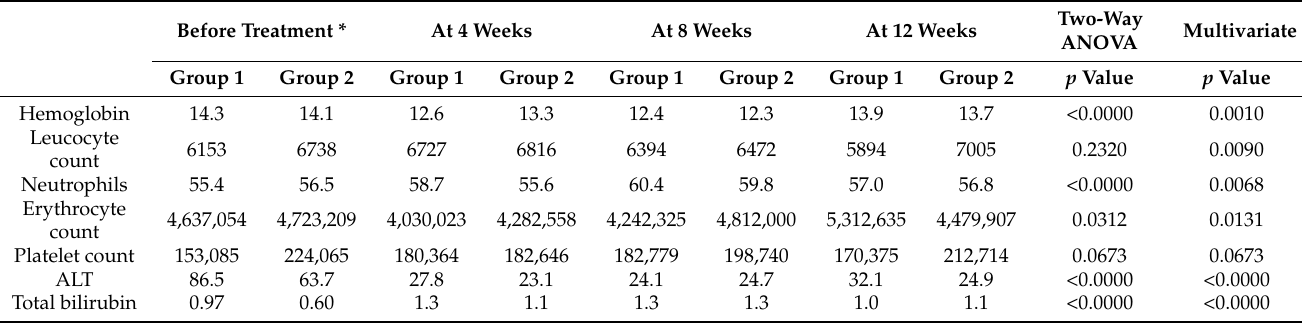
Table 2. Average values of blood tests during treatment comparing main hematological parameters evaluated by the average results obtained before treatment and the follow-up period. All data were compared by ANOVA between groups and by a multivariate method.